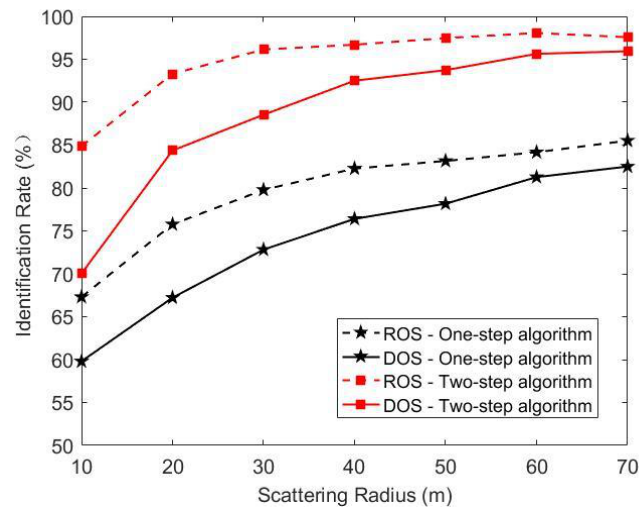
Figure 5. 𝑃 𝐼𝐸 versus scattering radius. Figure 5. P IE versus scattering